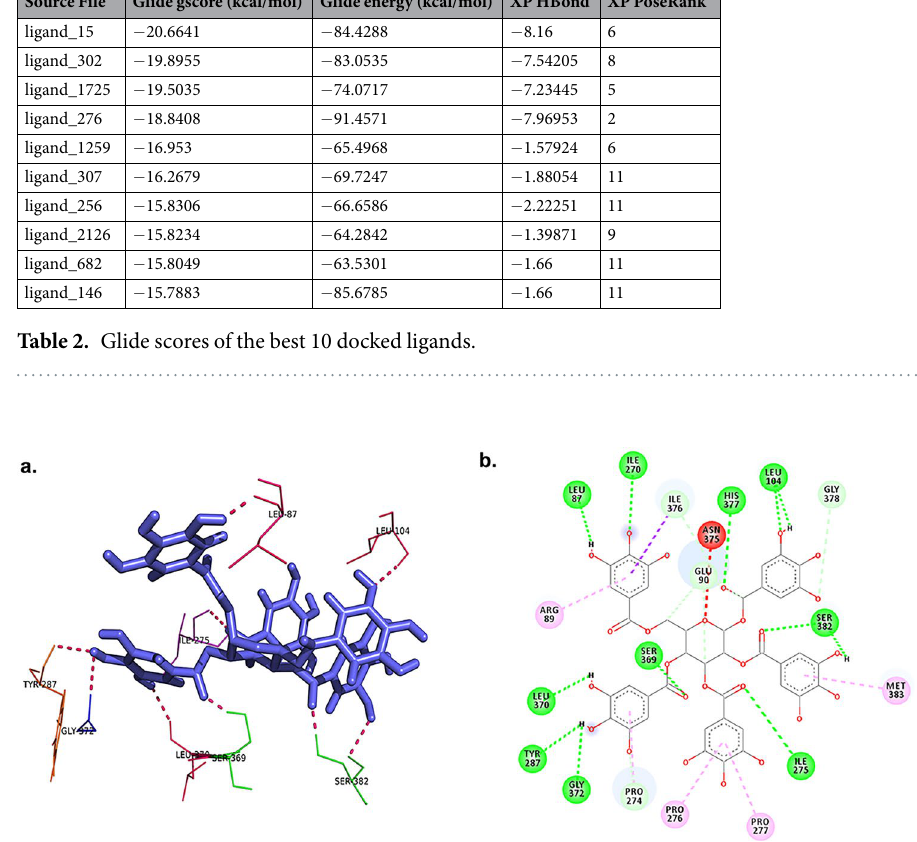
Figure 7. Hydrogen bond interactions within the Protein and ligand 15 complex ( a ) 3D-image ( b )